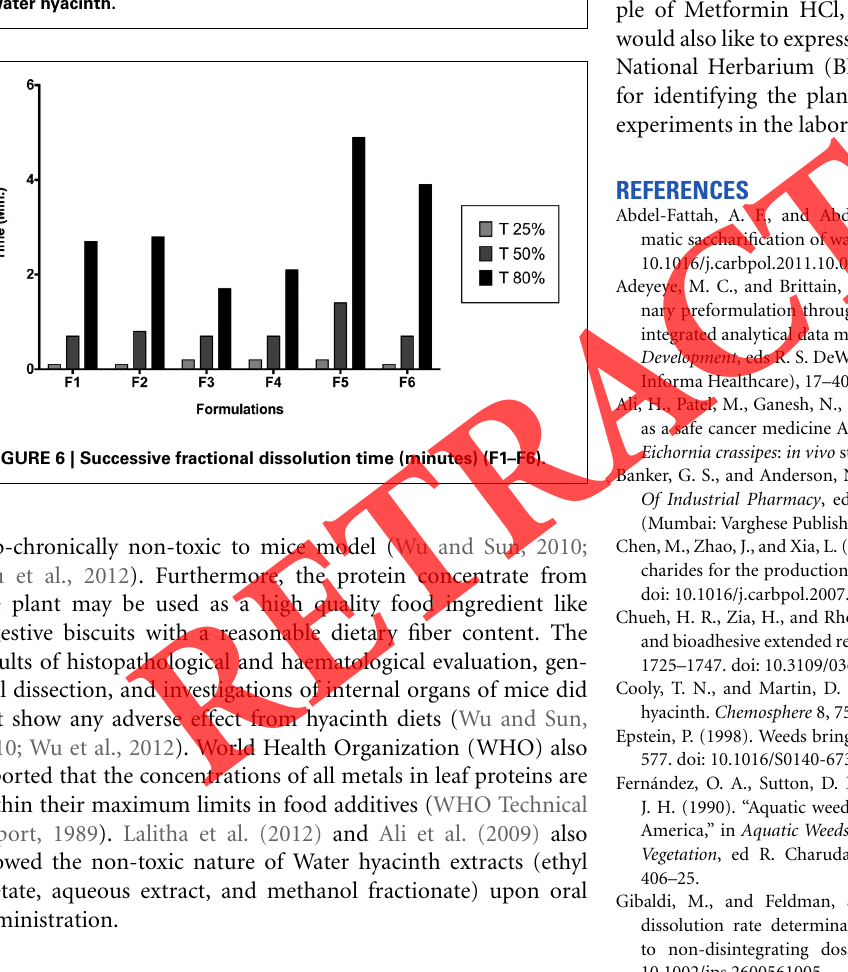
FIGURE 5 | Zero order release of Metformin HCl matrix tablets with Water hyacinth.